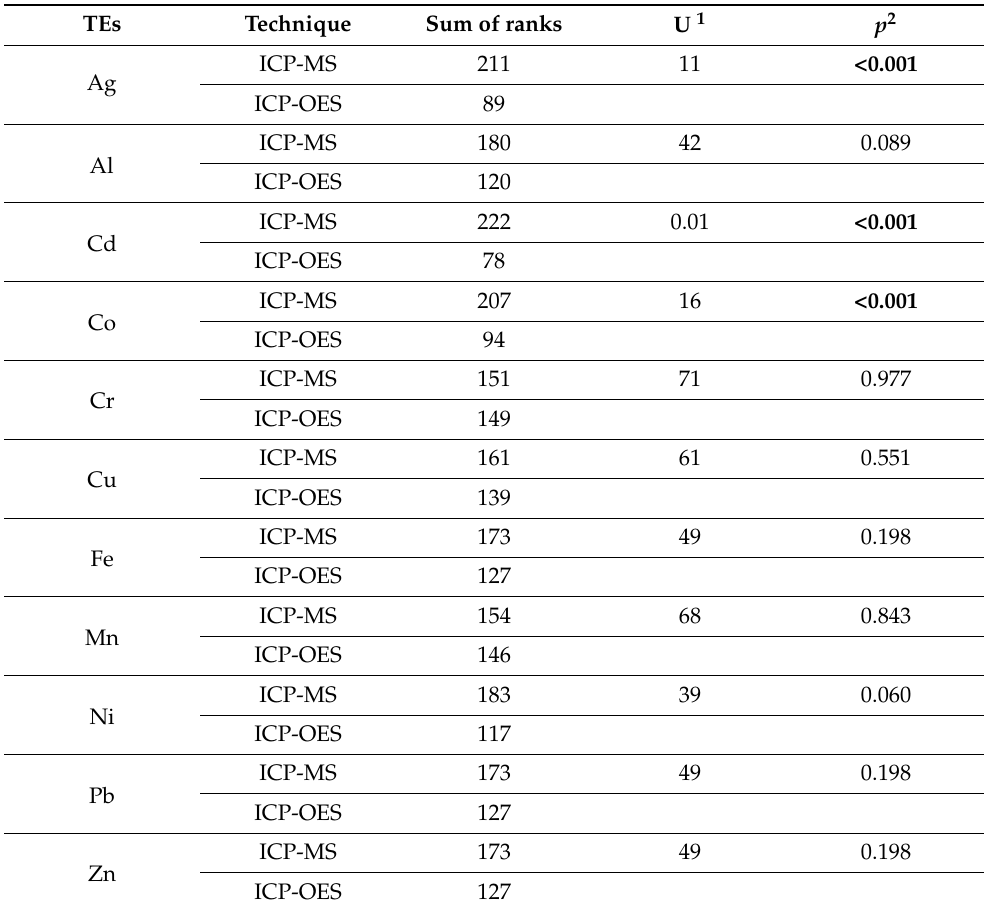
Table 4. Evaluation of the significant difference between the mean values of the analysed TEs calcu- lated using inductively coupled plasma-optical emission spectrometry (ICP-OES) and inductively coupled plasma-mass spectrometry (ICP-MS) measurement techniques from selected periods A–D ( N = 12). TEs Technique Sum of ranks U 1 p 2 ICP-MS 211 Ag